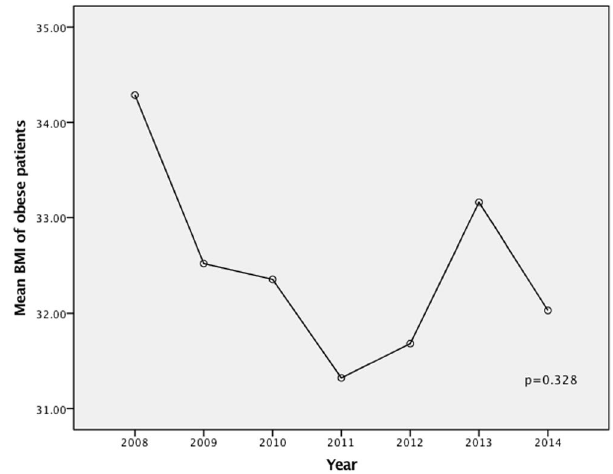
Figure 2. Mean BMI of obese patients according to year of